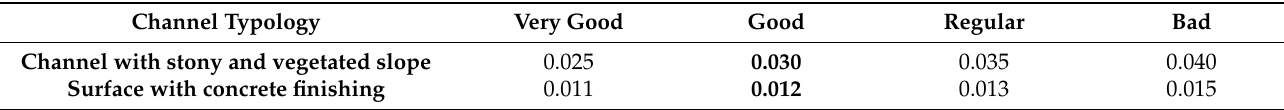
Table 10. Adopted roughness coefficient (Source: